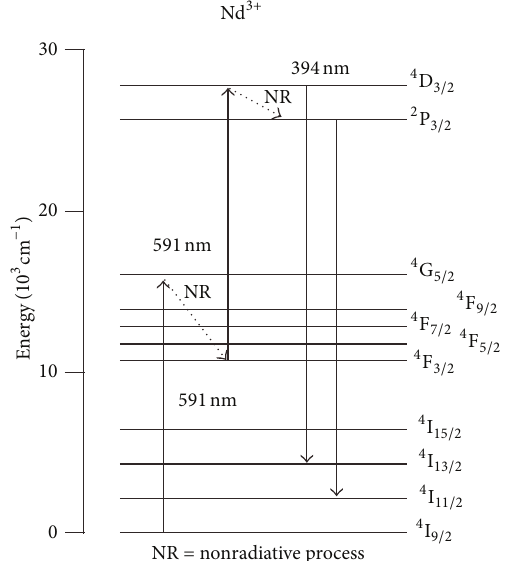
Figure 4: Upconversion luminescence spectra of Nd 3+ ions in Bi 2 O 3 –BaO–B 2 O 3 glasses when excited with 591 nm at room tem- perature.